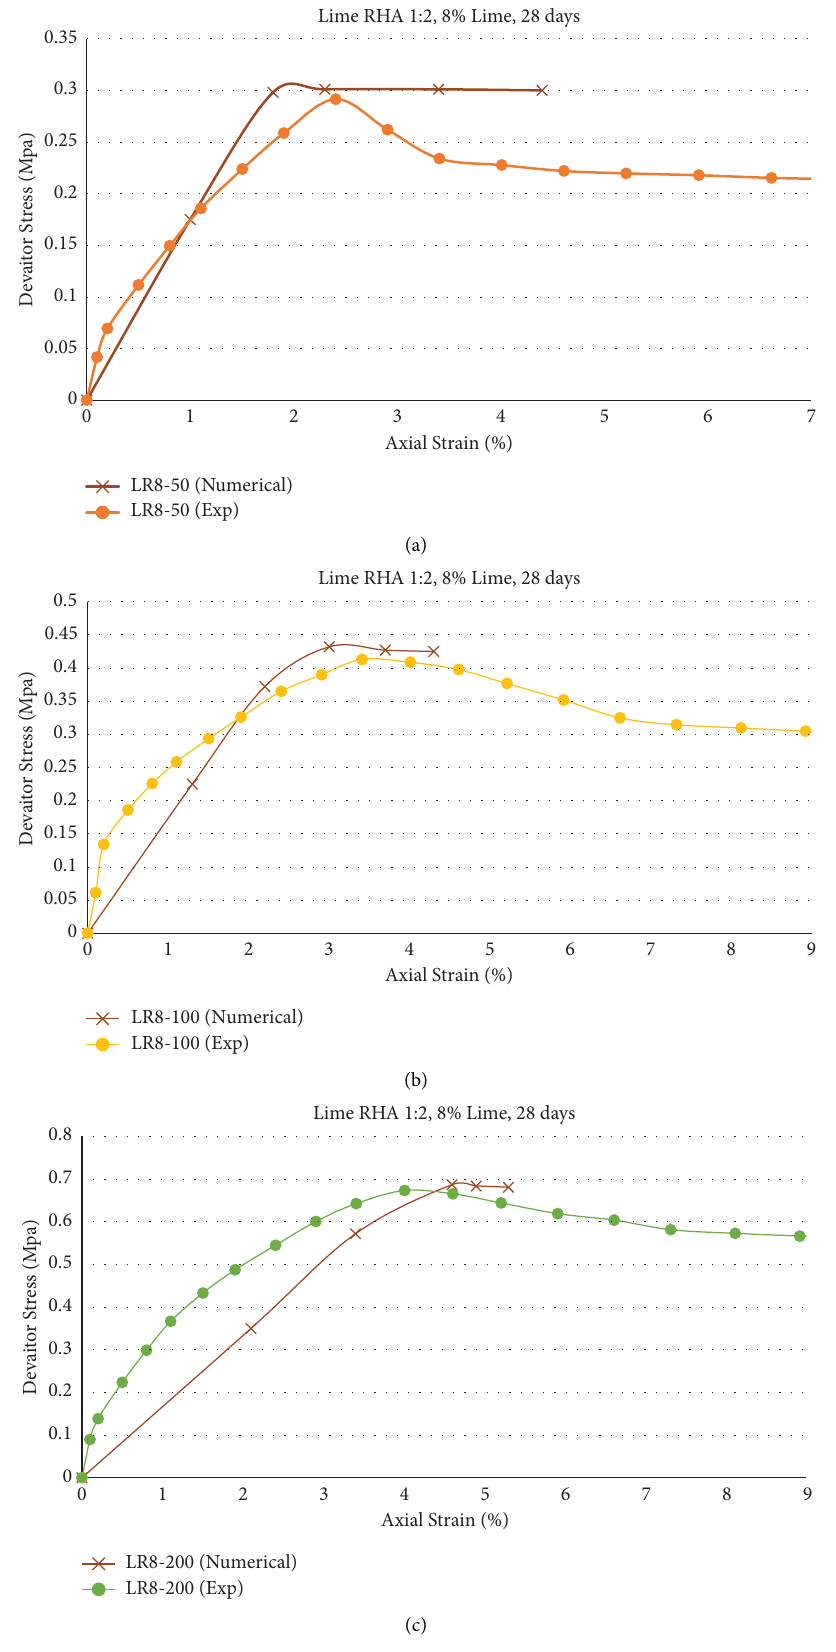
Figure 11: Deviator stress-strain curves for 8% LRHA treated soil (1:2) after 28 days of curing, under three diferent confning pressures of (a) 50, (b)100, and (c)